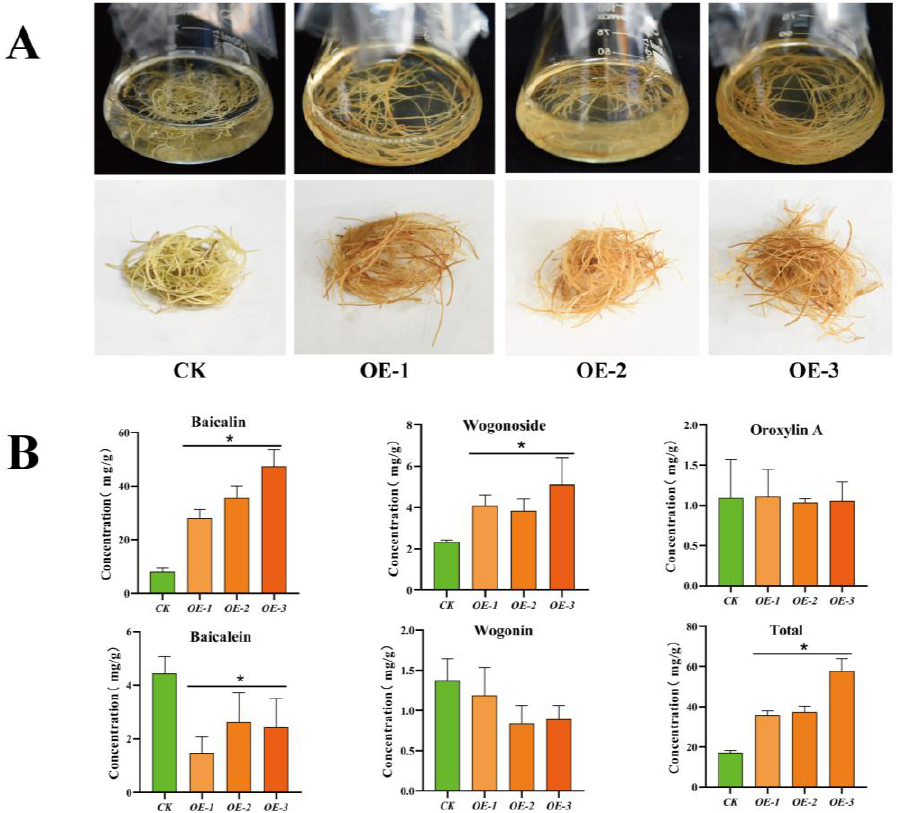
Figure 6. SbMYB12 promoted the accumulation of flavonoids (baicalin and wogonoside) in S. baicalensis transgenic hairy roots. ( A ) Phenotypes of the two-month-old SbMYB12 -overexpression (OE) lines and the control (CK). ( B ) Concentrations of flavonoids in the transgenic hairy roots and the control (CK). Significant differences between the OE lines and the CK were identified (depicted by * p < 0.05) via Student’s t -test.